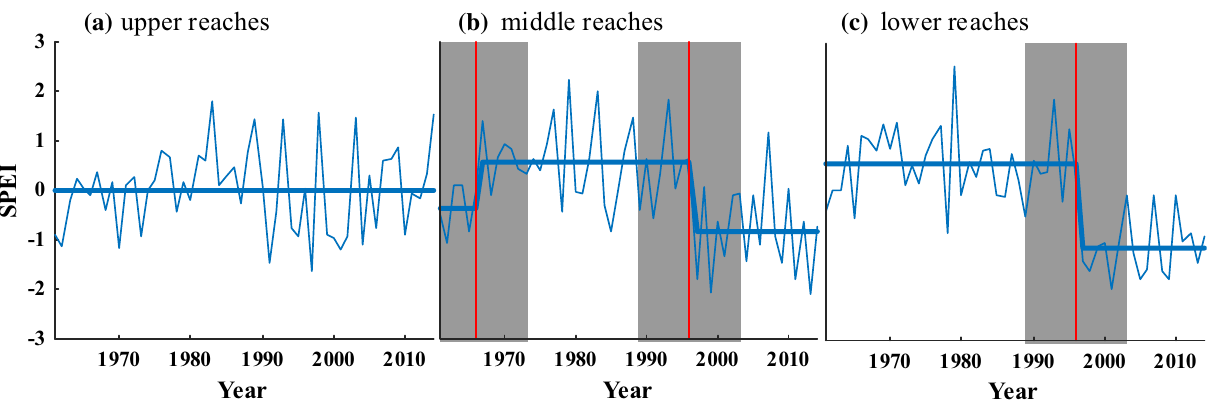
Fig. 7 The mutation points of annual scale interannual standardized precipitation evapotranspiration index (SPEI) series in the Heihe River Basin during